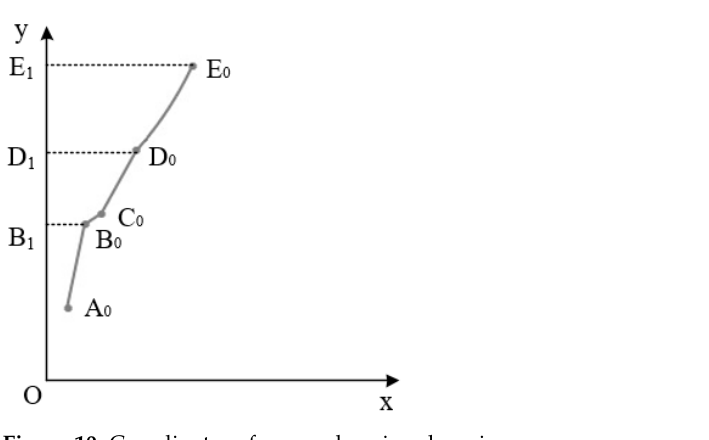
Figure 10. Coordinates of comprehensive clamping curve.